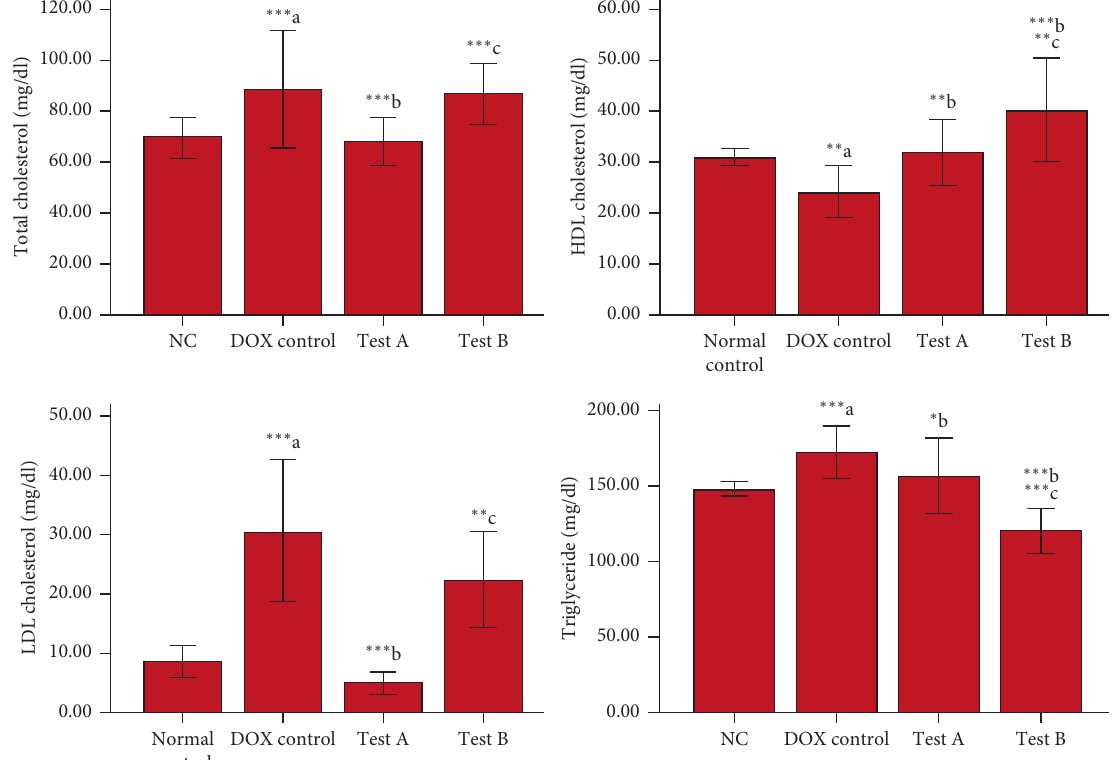
Figure 4: Effect of DOX and methyl gallate on lipid profile. Data were represented as mean ± SD, one-way ANOVA followed by Tukey’s post hoc test ( ∗ ∗ ∗ p ≤ 0.001, ∗ ∗ p ≤ 0.01, and ∗ p ≤ 0.05; a compared to control, b compared to DOX control, and c compared to methyl gallate 150mg/kg), NC: normal control, test- A: methyl gallate 150mg/kg, and test-B: methyl gallate